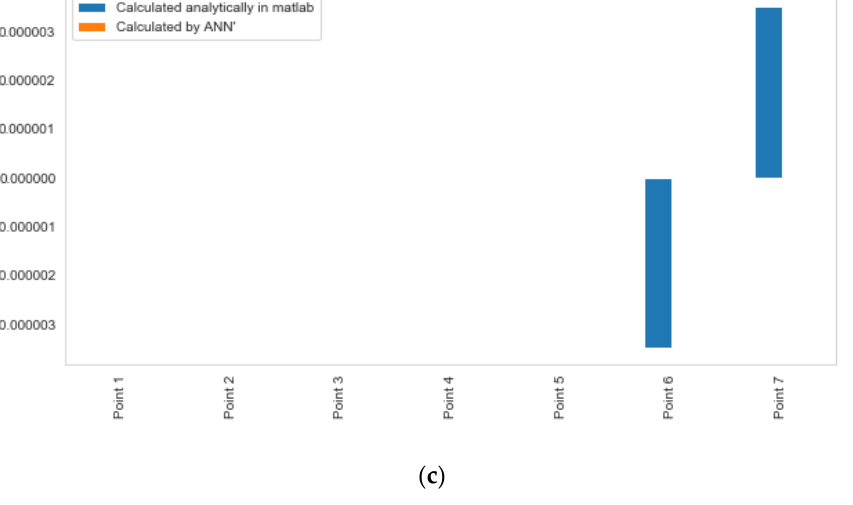
Figure 6. Analysis of differences in analytical and ANN results: ( a ) for X coordinates, ( b ) for Y coordinates, ( c ) for Z. Table 2. Transformation of coordinates of a virtual point cloud.